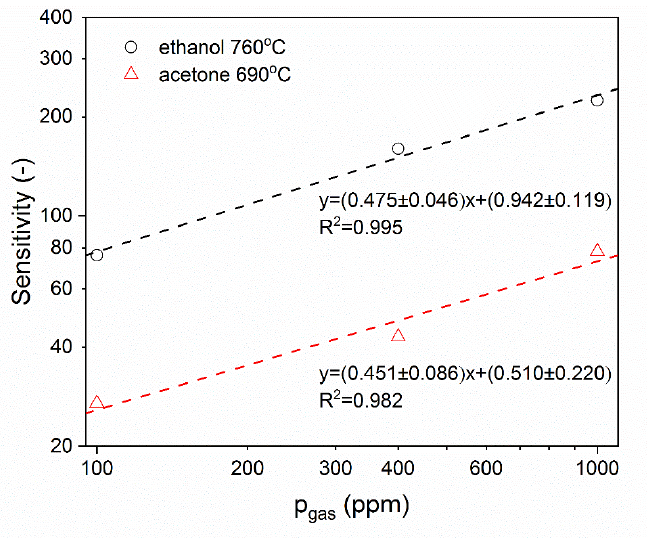
Figure 17. The sensitivity of β -Ga 2 O 3 nanowires as a function of ethanol or acetone partial pres-